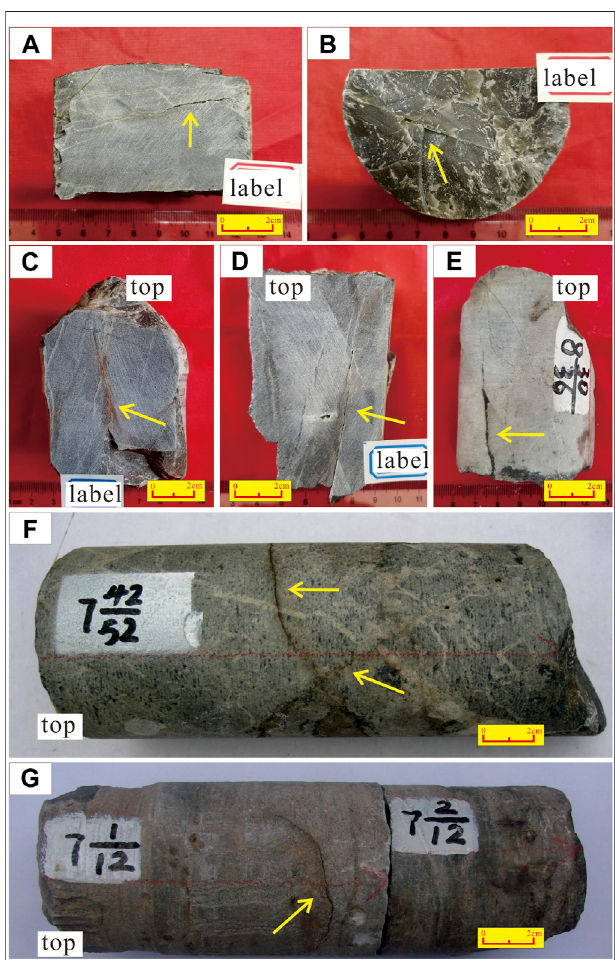
FIGURE 3 | Fracture development characteristics from core sections in the Sandaoqiao gas fi eld. (A,B) , well Q1, Z, 5,754.8 m, gray fi ne-grained dolomite, half- fi lled fracture; (C) , well Q101, ∈ , 5,758 m, light-red-oil-trace dolomite,high-anglefracture; (D) ,wellQ101, ∈ ,5,761.04 m,gray-black- oil-trace silty siliceous dolomite, high-angle fracture development, half- fi lled; (E) ,wellQ101, ∈ ,5,761.08m,gray-black-oil-tracesiltysiliceousdolomite. (F) , well, Q1, Z, 5,753.98 – 5,754.14 m, two intersecting oblique fractures with a width of 0.1 – 0.5 mm; (G) ; well, Q101, ∈ , 5,757 – 5,757.19 m, gray-black calcareous dolomite, 1 inclined fracture, approximately 8 cm in length and 0.1 mm in width.